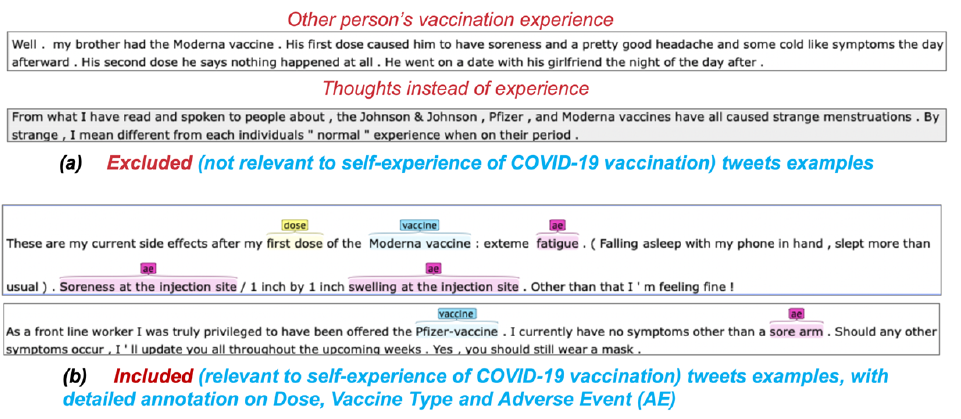
Figure 2. Process of annotation. ( a ) Two sample tweets that were excluded for further annotation ( b ) One sample tweet with annotation result. Evaluation: The annotated tweets were divided into